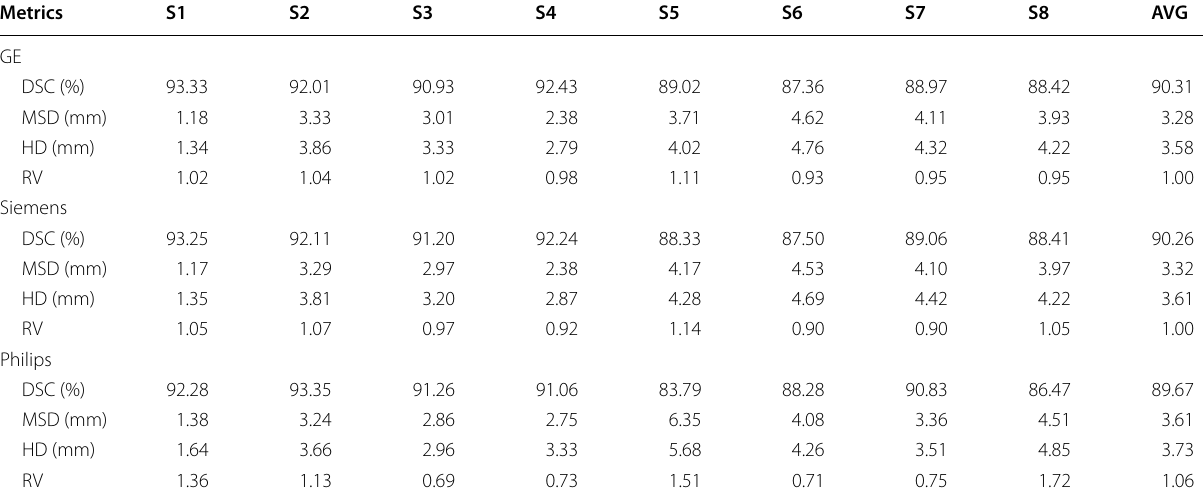
Table 3 Quantitative evaluation results by different MR